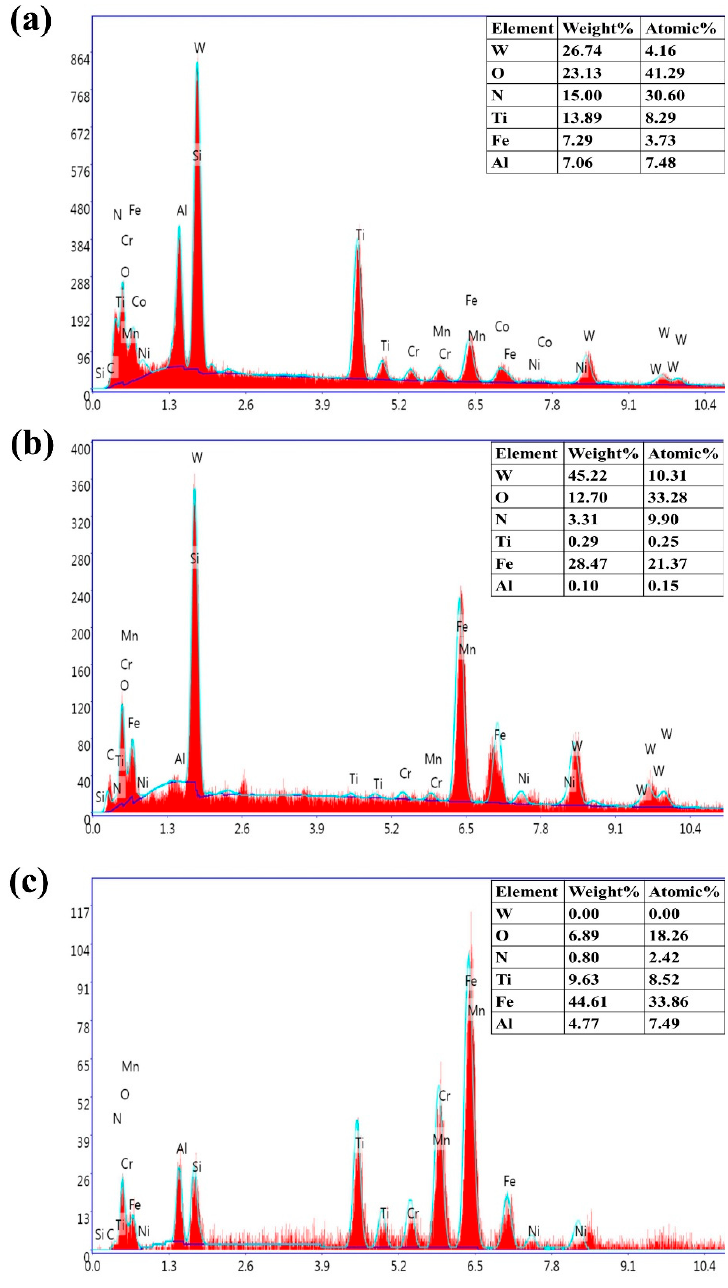
Figure 11. Cont. Figure 11.